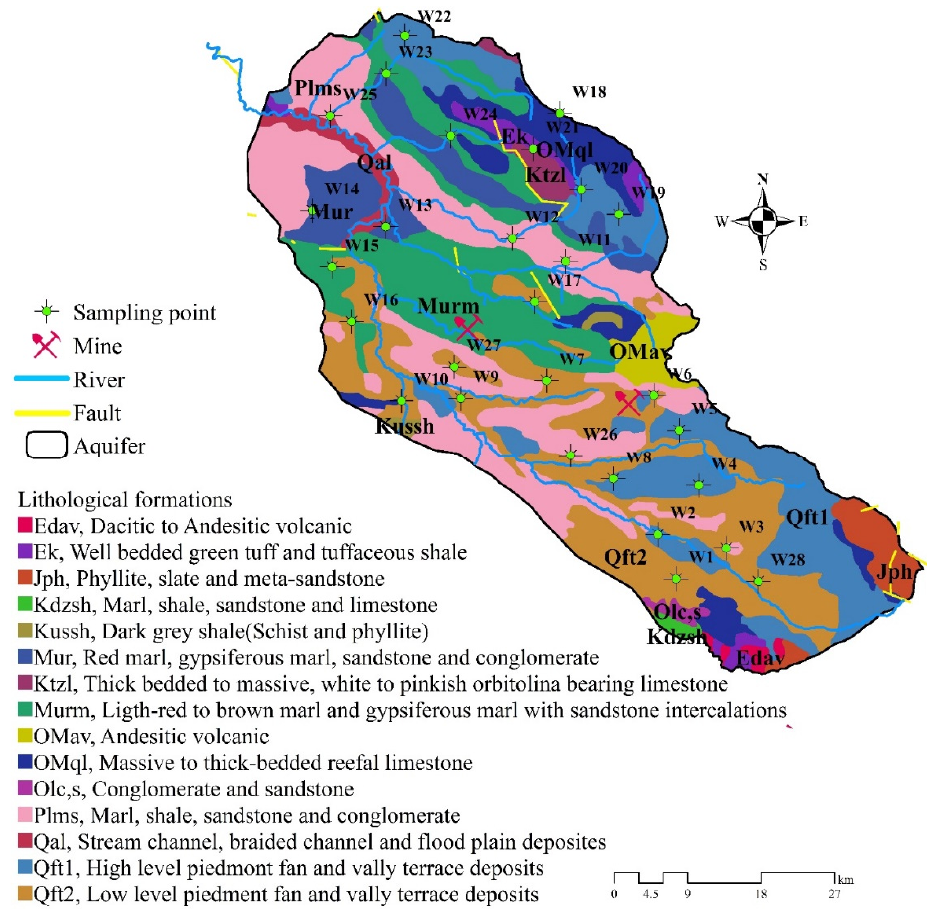
Figure 2. Lithological map of the study area and location of sampling sites.